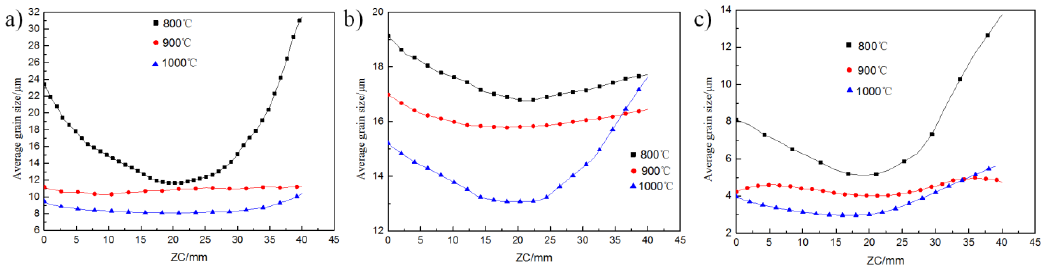
Figure 11. Recrystallized grain size (RGS) curve of forgings at different temperatures under different processes: ( a ) CMDF, ( b ) single-open MDF, and ( c ) double-open MDF.